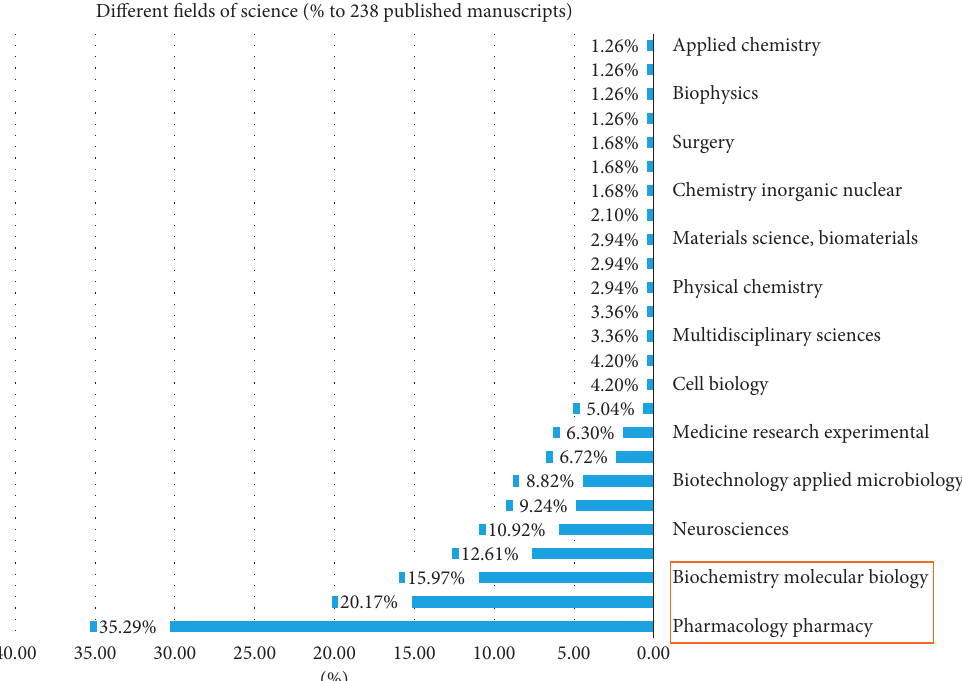
Figure 1: Different fields of science interested in using nanotechnology for the management of